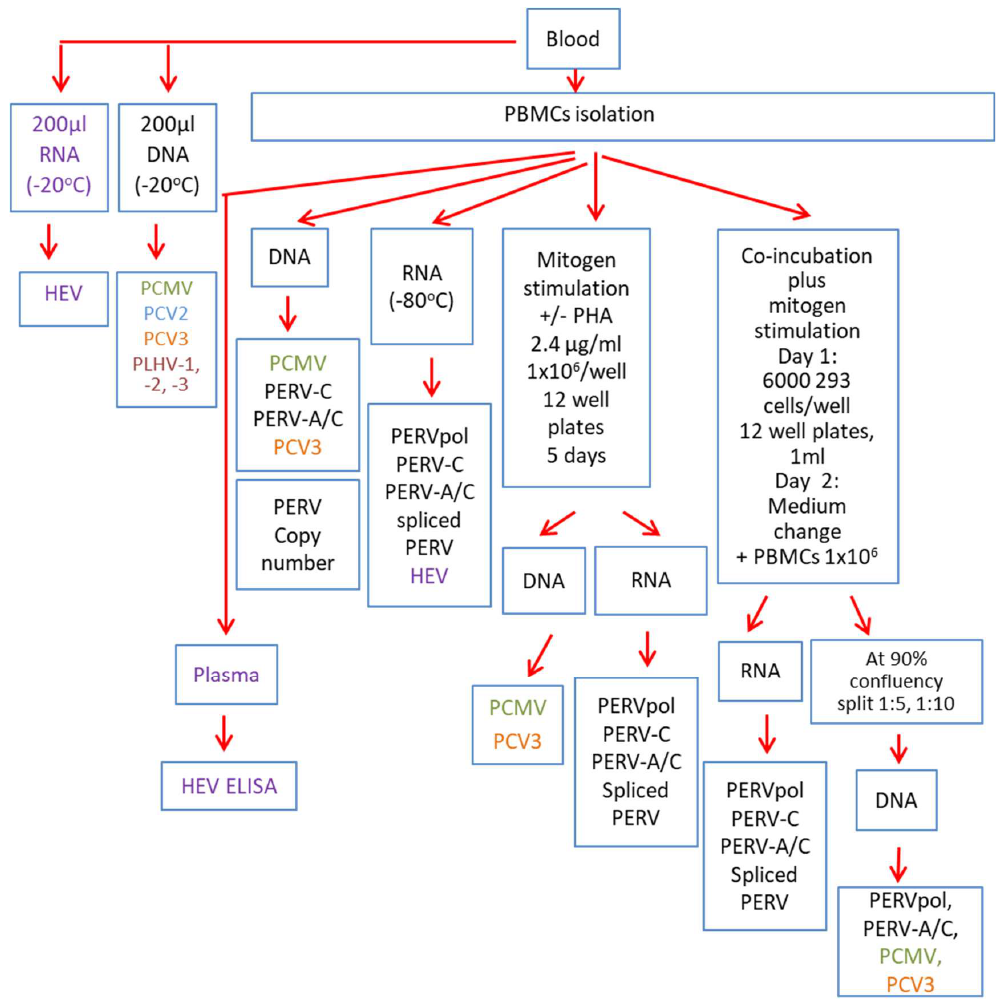
Figure 1. Schematic presentation of the screening strategy.